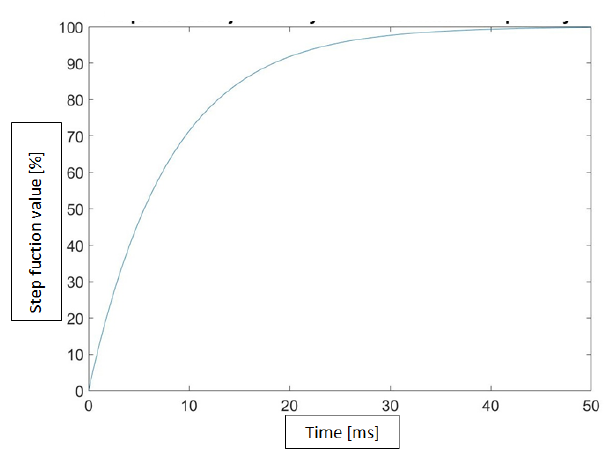
Fig. 8. Sensor response to temperature step function